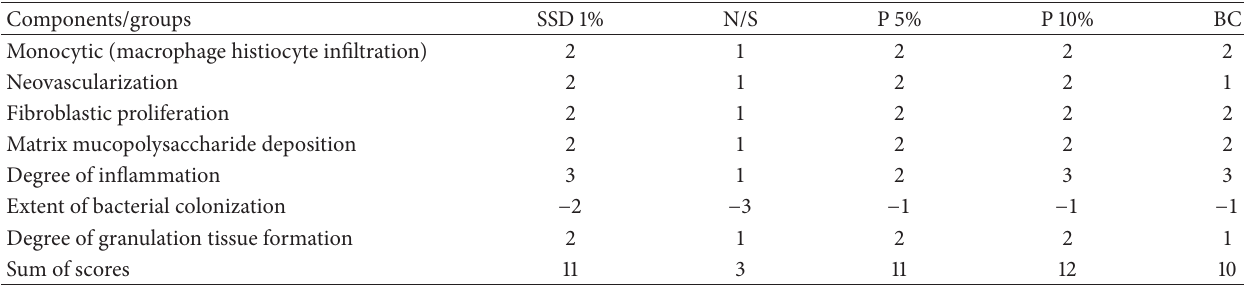
Table 2: Morphology and histopathology of granulation tissue examined in different groups on the 8th day after burn injury ∗ . Components/groups SSD 1% N/S P 5% BC Monocytic (macrophage histiocyte infiltration) Neovascularization Fibroblastic proliferation Matrix mucopolysaccharide deposition